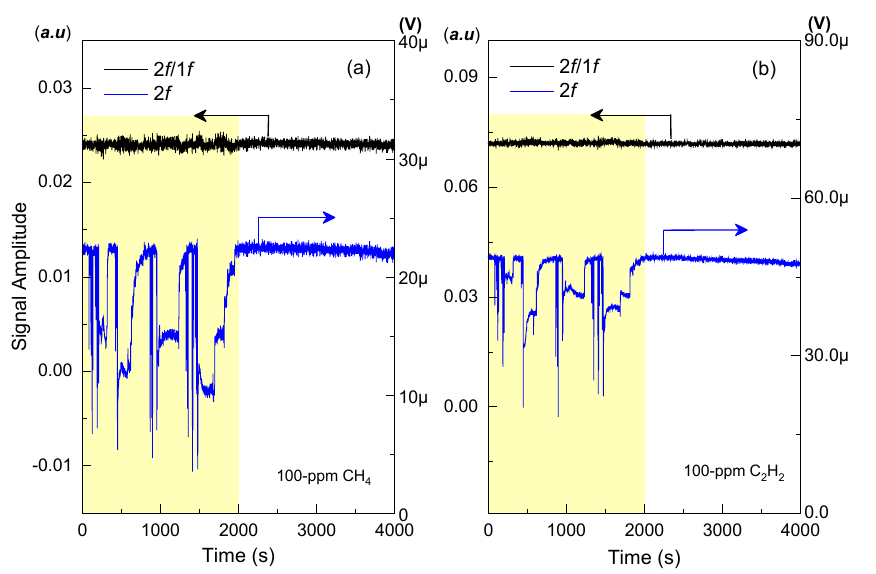
Figure 7. Long-term monitoring of sample gas mixture sealed in the chamber, illustrating a comparison between 2 f /1 f results and 2 f results for both ( a ) 100-ppm CH 4 and ( b ) 100-ppm C 2 H 2 . The left axes pointed by the black arrows mean the amplitude of 2 f /1 f signal, and the right axes pointed by the blue arrows mean the amplitude of 2 f signal.